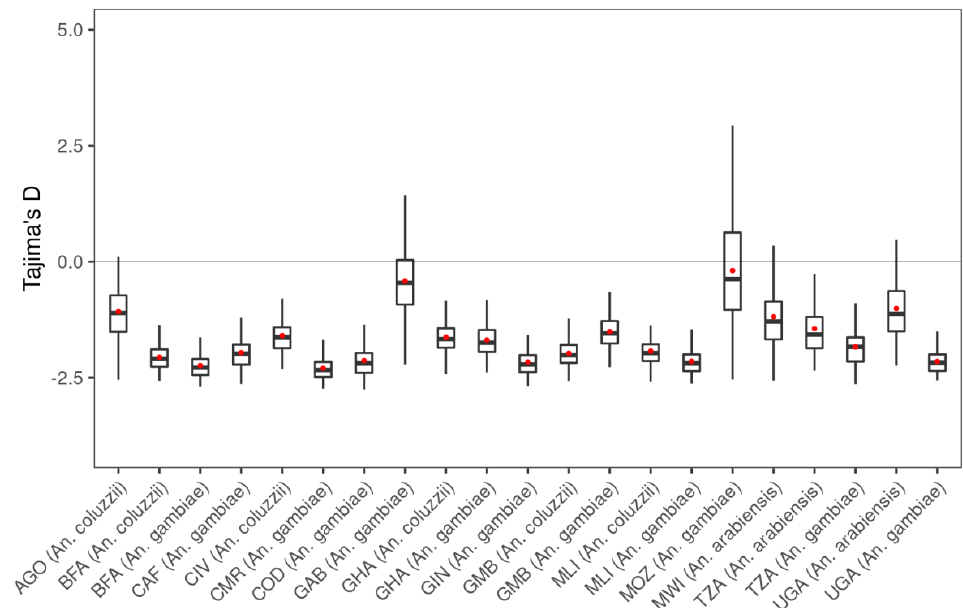
Figure A3. Median of Tajima’s D in a window of 500 bp across the genomic region of the Fruitless gene; red points indicate the mean of the Tajima’s D. Horizontal line indicates the null value of the Tajima’s D test. AGO: Angola; BFA : Burkina Faso; CAF : Central African Republic; CIV : Côte d’Ivoire; CMR : Cameroon; COD : Democratic Republic of Congo; GAB : Gabon; GHA : Ghana; GIN : Guinea; GMB : Gambia; MLI : Mali; MOZ : Mozambique; MWI : Malawi; TZA : Tanzania; UGA : Uganda.